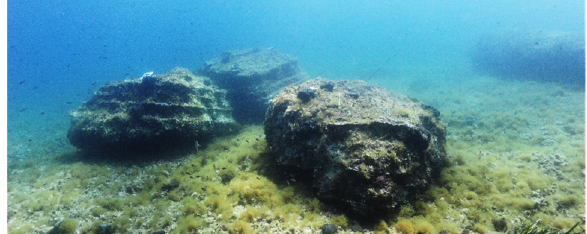
Figure 1. Squared blocks of the site